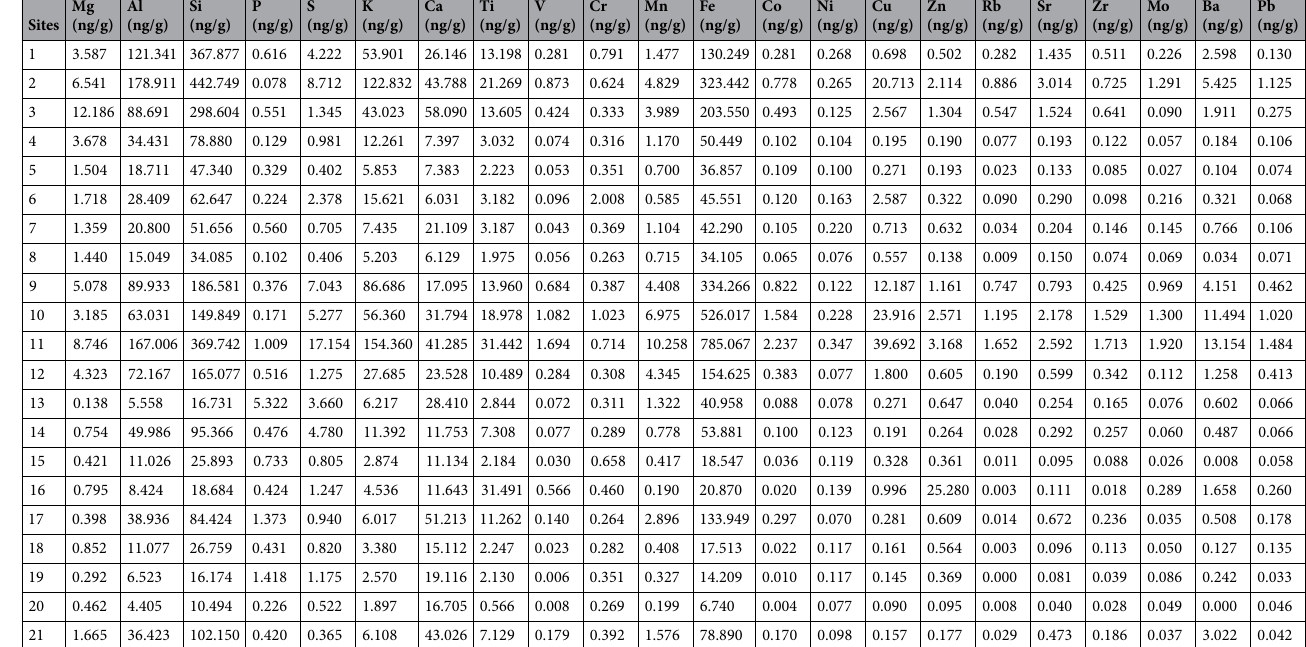
Table 2. Best estimates of the element concentrations (ng of the element per g of snow) in the snow sampled at each site.